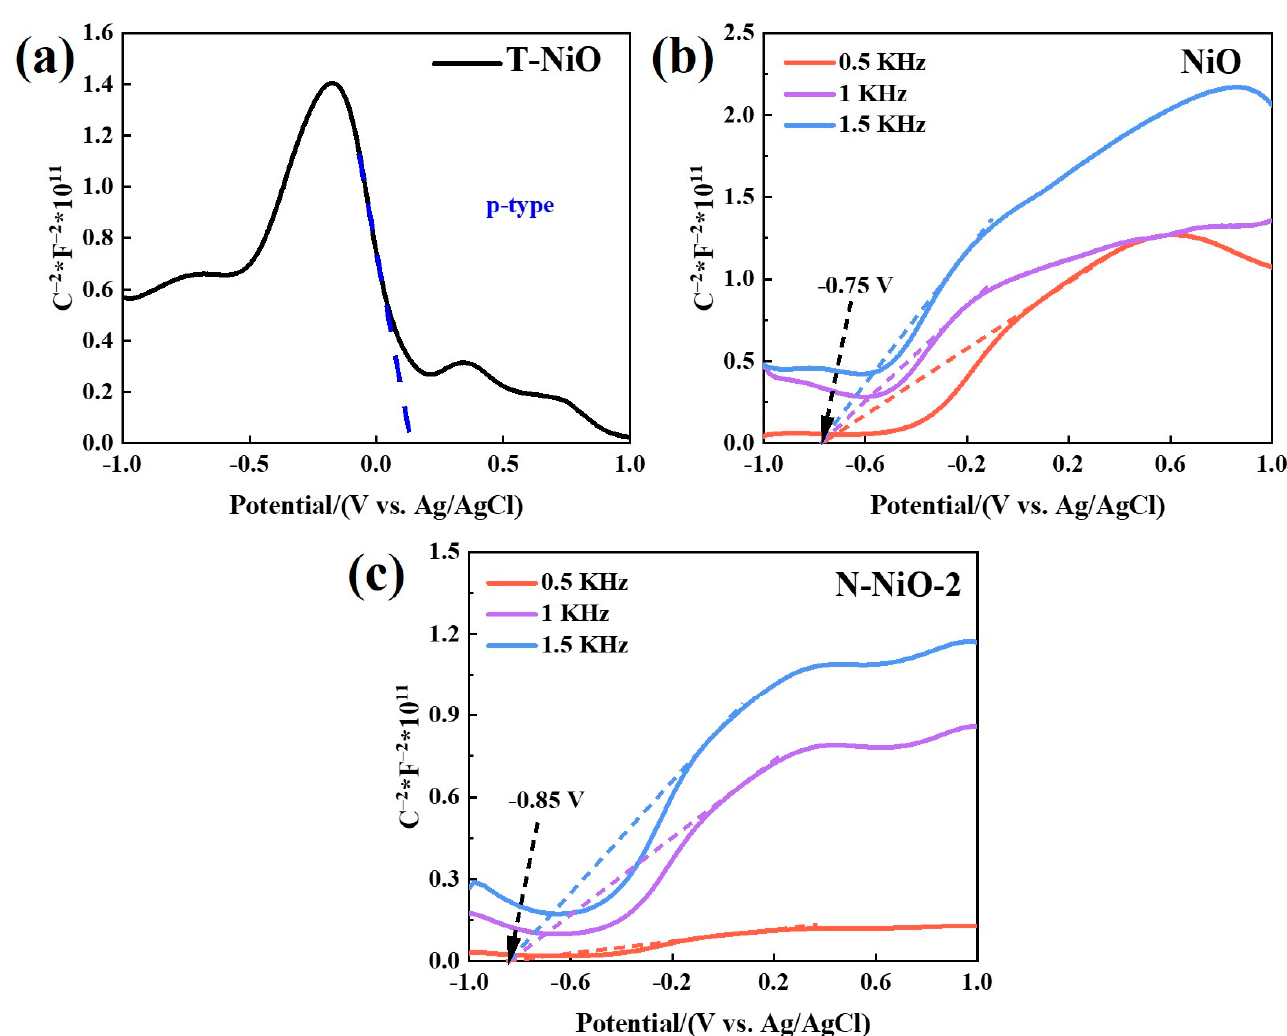
Figure 8. The M–S diagrams of T-NiO ( a ), NiO ( b ), and N-NiO-2 ( c ) semiconductors.